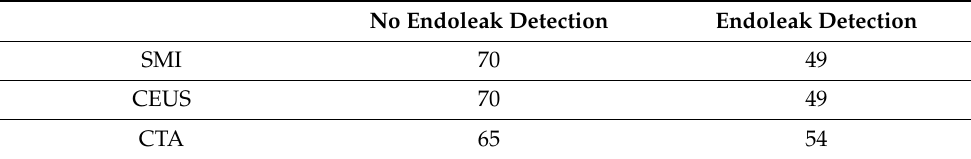
Table 2. Results of endoleak detection with SMI, CEUS, and CTA.